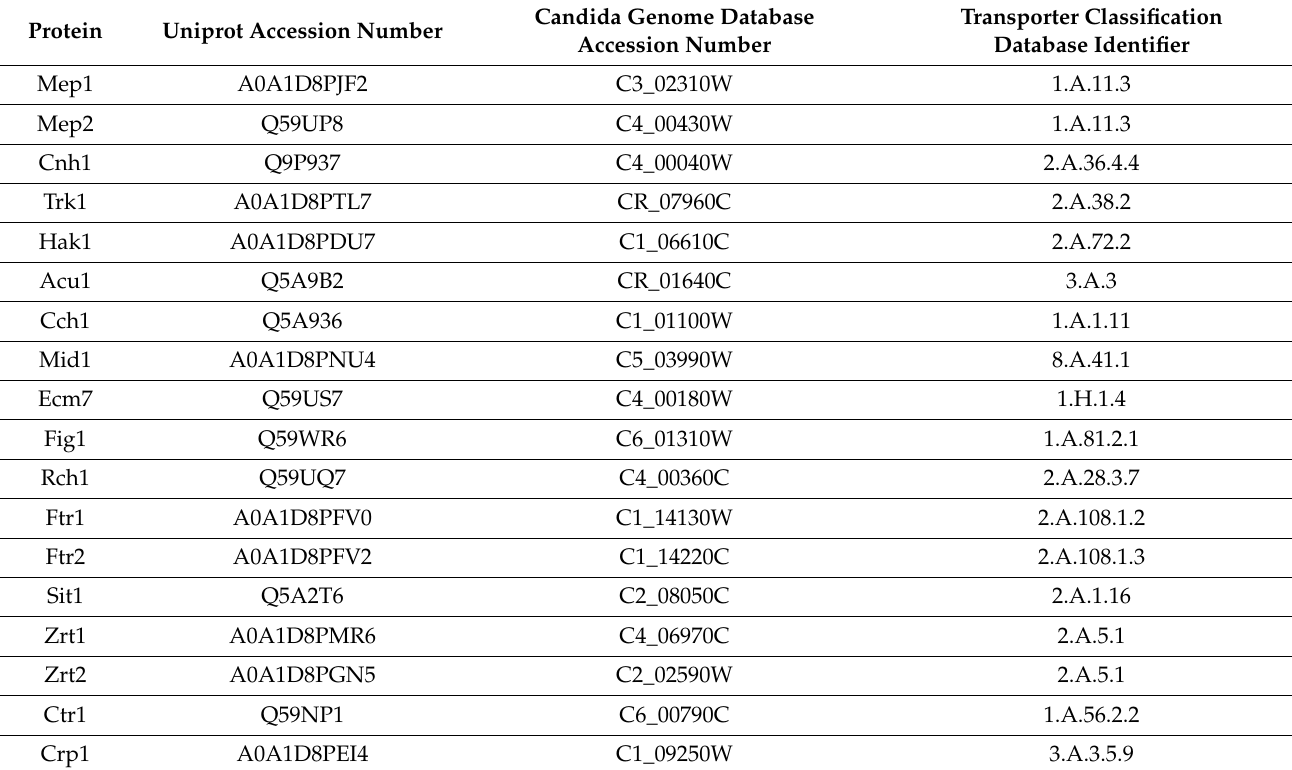
Table 1. Unique identifiers for proteins discussed in this